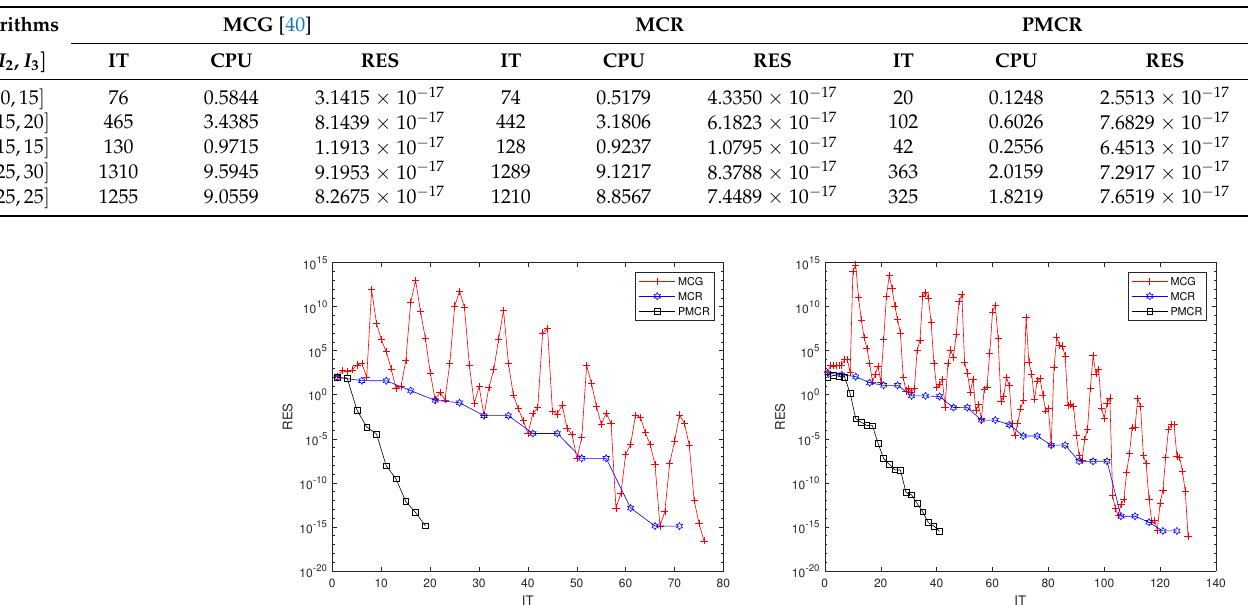
Table 3. Comparison results of Example 3.